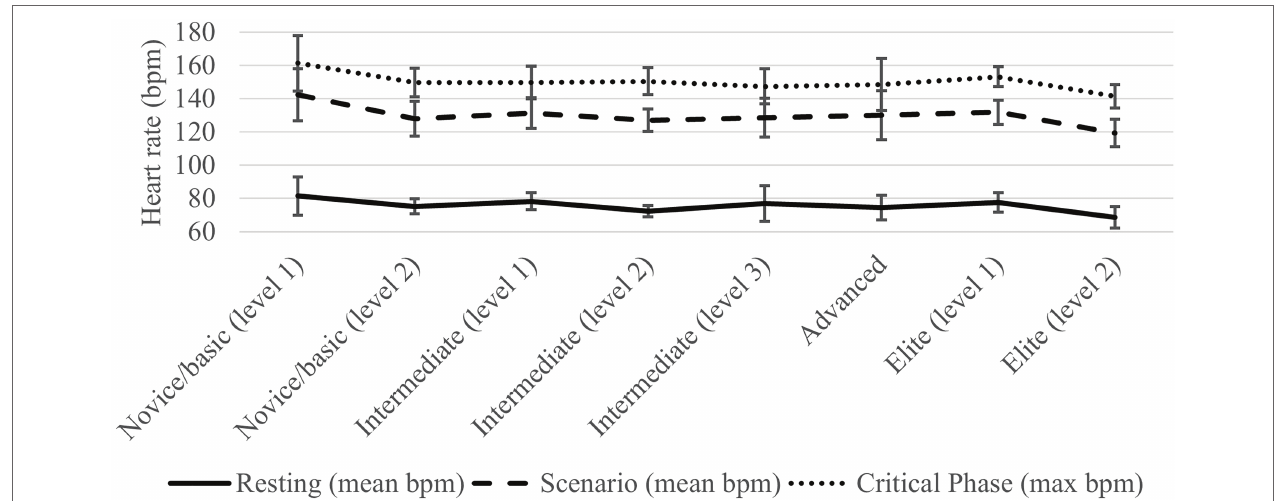
FIGURE 3 | Heart rate as a function of level of training. bpm, beats per minute. 95% CI error bars displayed.